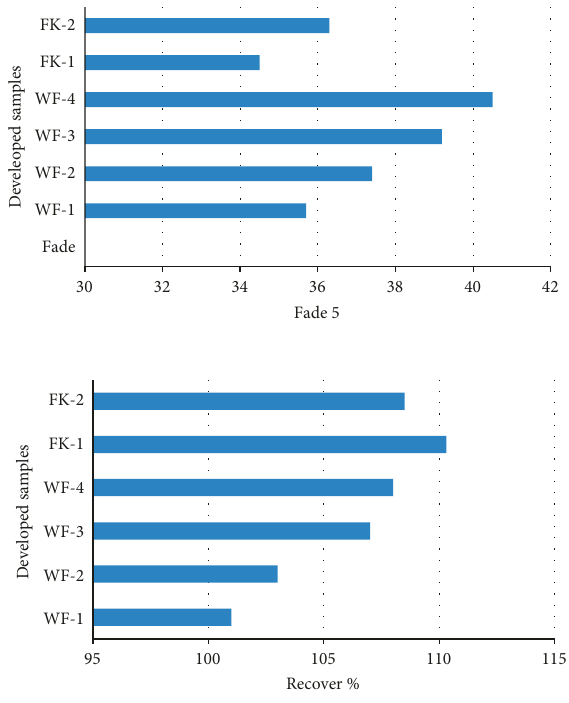
Figure 7: Fade percentage and recovery percentage new developed composites.